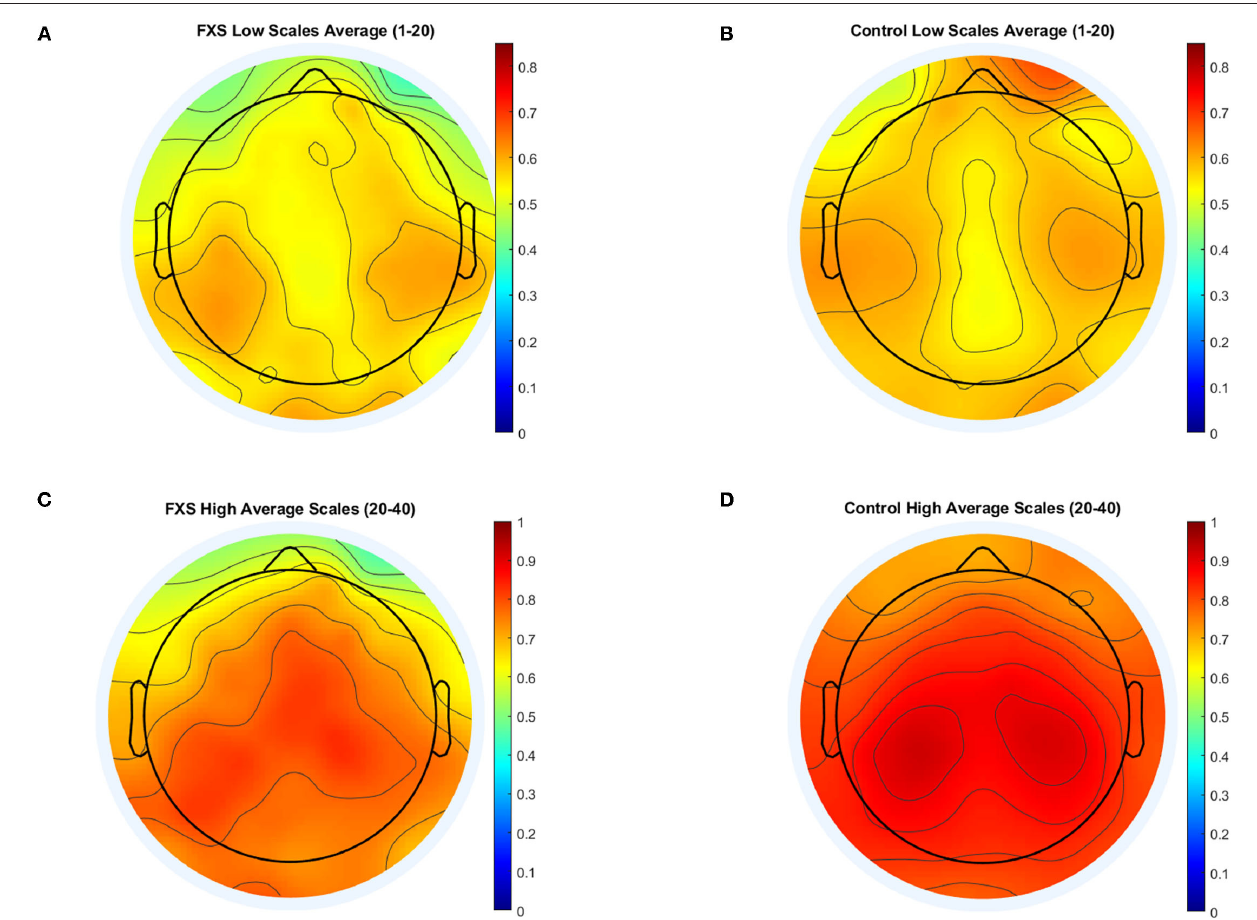
FIGURE 8 | Topographic representation of averaged time scales: lower time scales (1–20) for FXS (A) and controls (B) and higher time scales for FXS (C) and controls (D) .